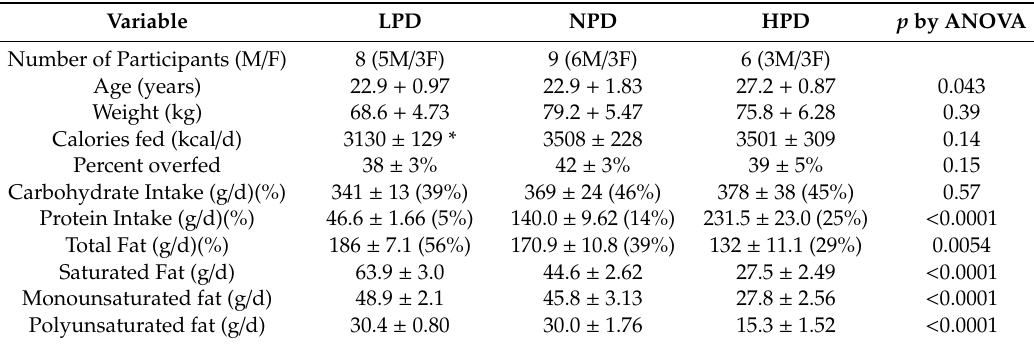
Table 1. Diet composition during